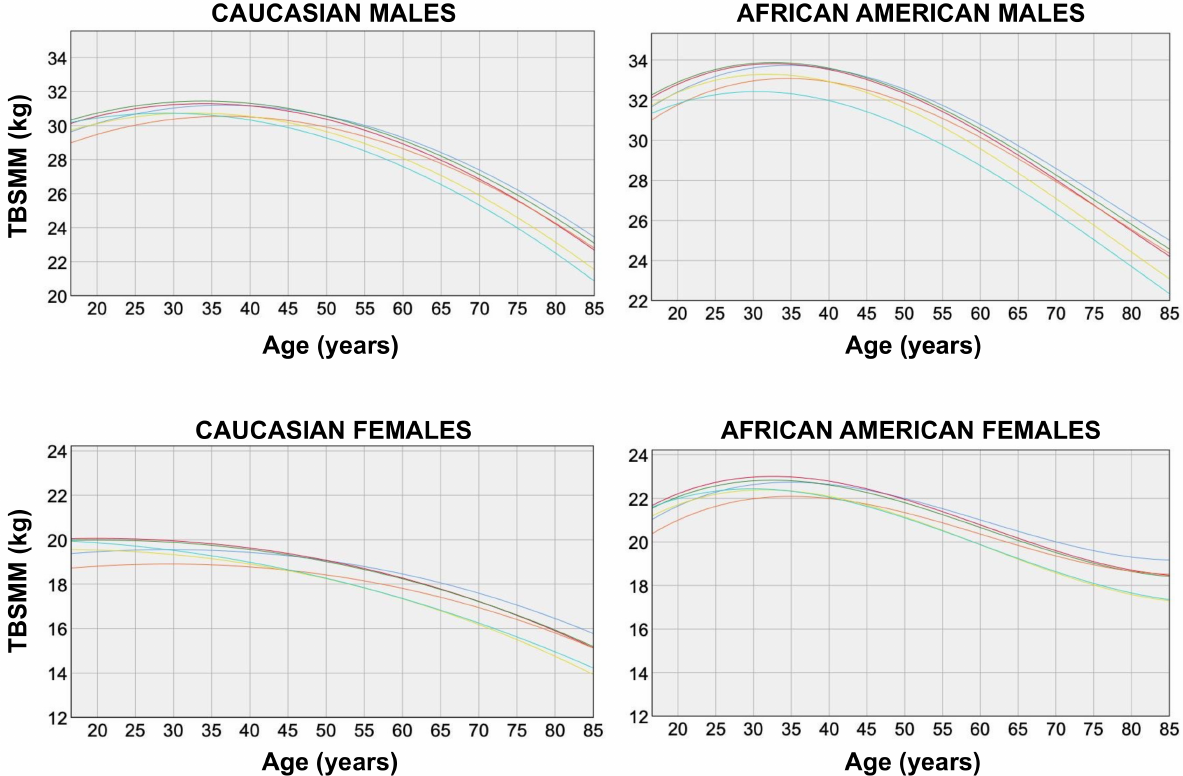
Figure 2. Total body skeletal muscle mass (TBSMM) vs. age in males (top panels) and females (bottom panels) of the two ethnic groups. TBSMM estimations were obtained according to the six equations previously proposed by Kim et al. [10,11]: blue, Equation #1; red, Equation #2; green, Equation #3; orange, Equation #4; yellow, Equation #5; light blue, Equation